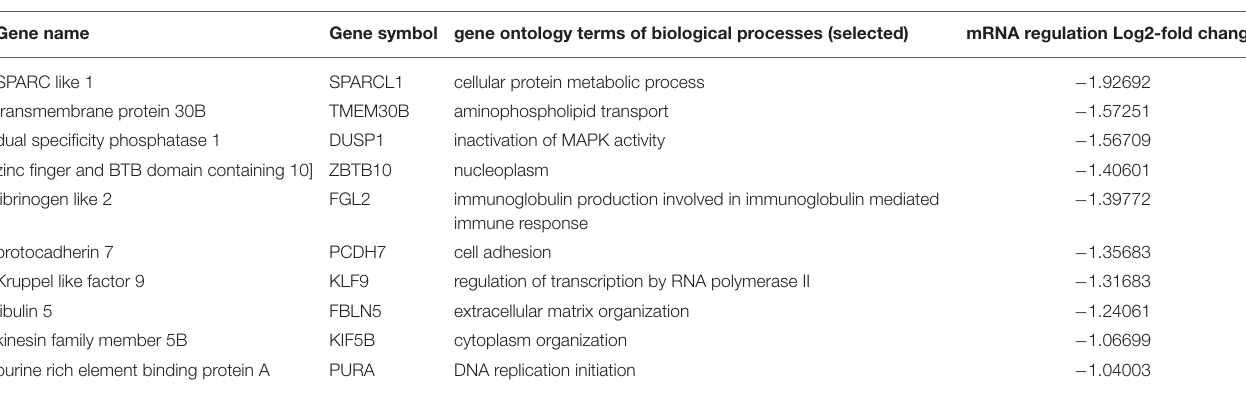
TABLE 6 | DMM overlap with down-regulated